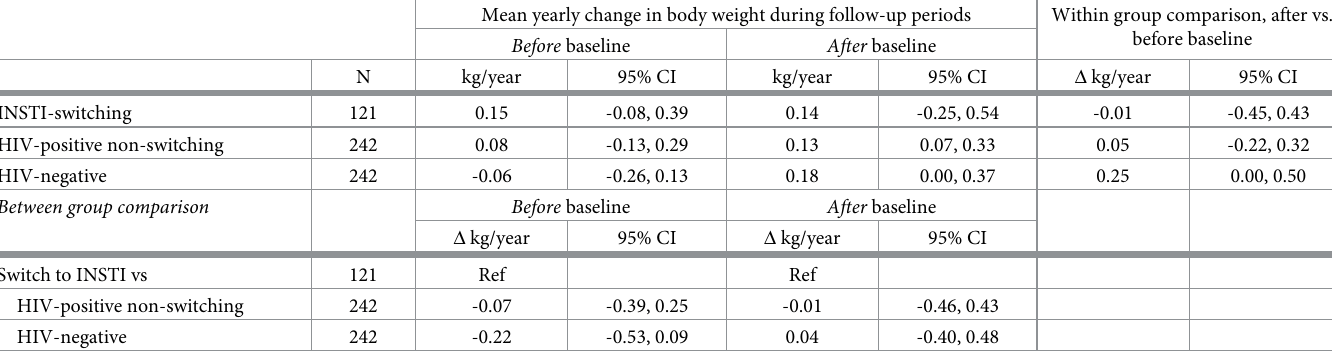
Table 2. Comparison of mean yearly changes in bodyweight by study group, before and after baseline. Mean yearly change in body weight during follow-up